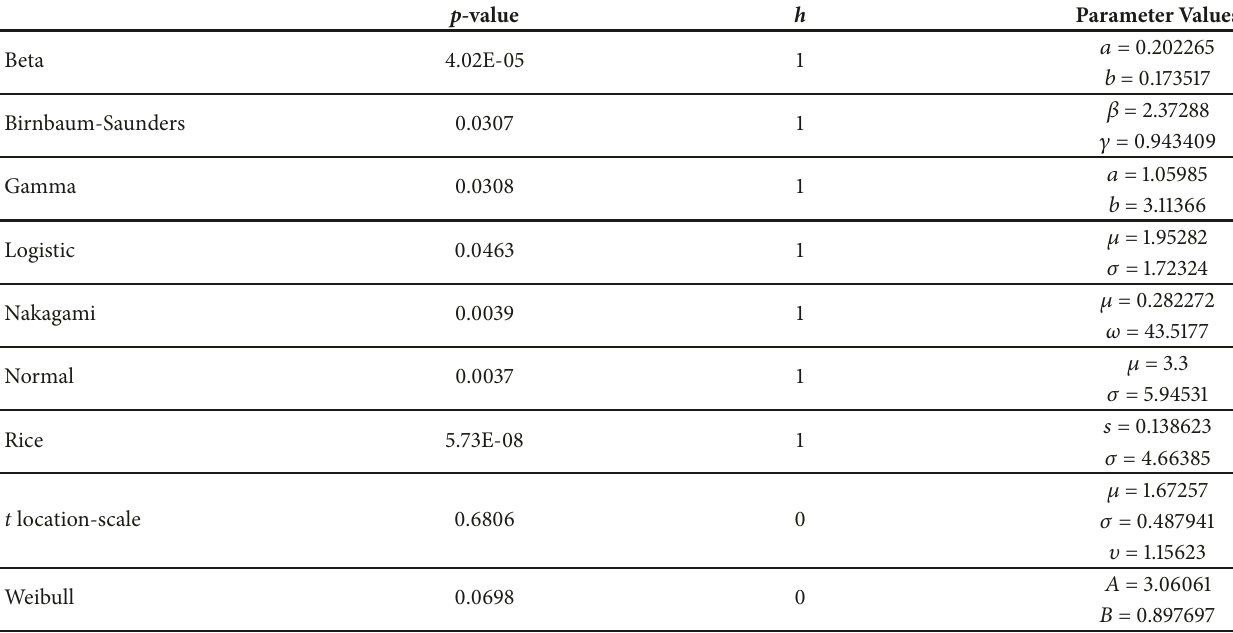
Table 6: Distribution inference of Carme group without Erinome (S/2000 J4).